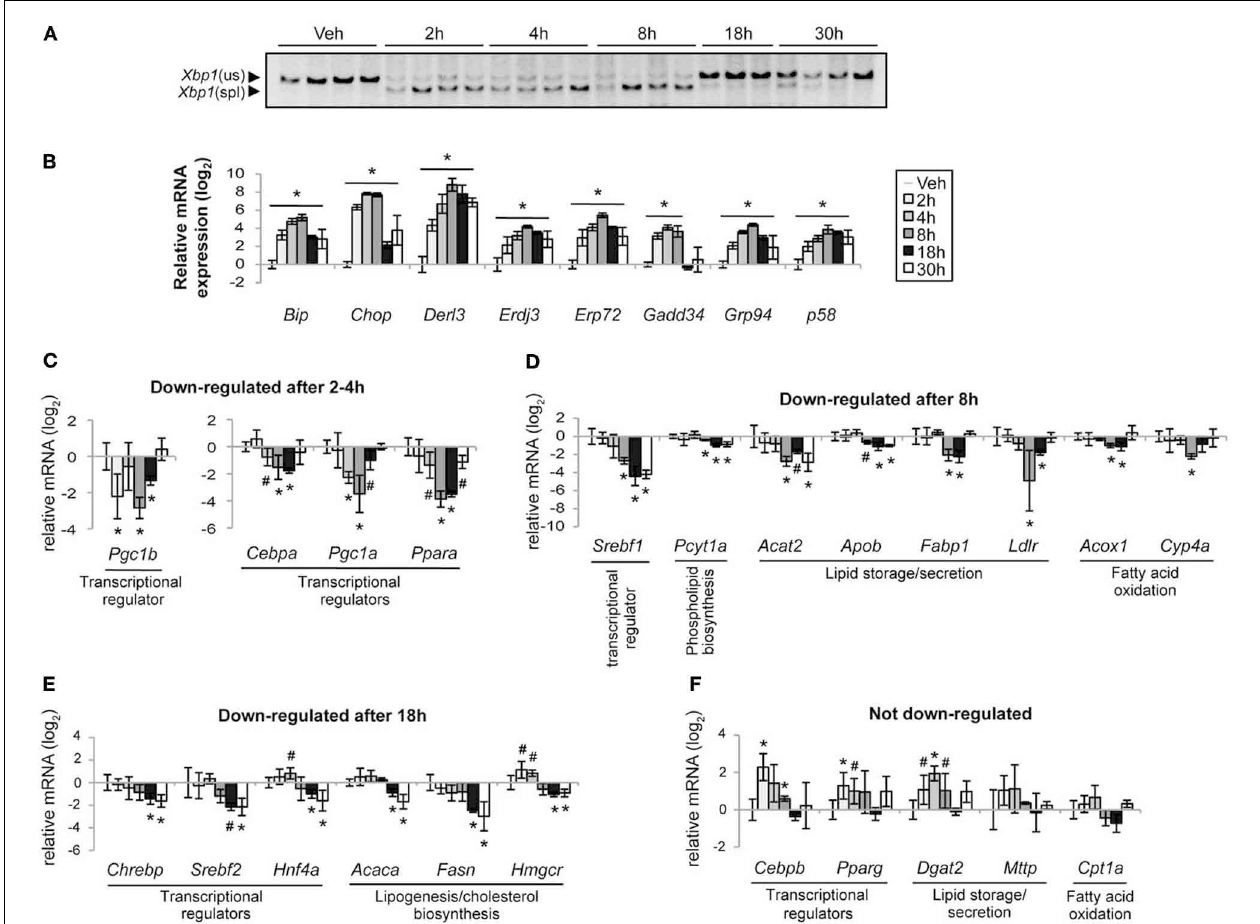
FIGURE 2 | Staggered suppression of metabolic genes during ER stress. (A) The spliced (spl) and unspliced (us) forms of Xbp1 mRNA were detected by RT-PCR of total RNA isolated from the livers of mice treated with vehicle (veh) or 1mg/kg TM for the indicated times. Each lane shows a separate animal. Image is shown in black-to-white inverted form for greater visual clarity. (B) Expression of the indicated UPR target genes was determined by qRT-PCR from the animals shown in (A) , with Btf3 and Ppia used as